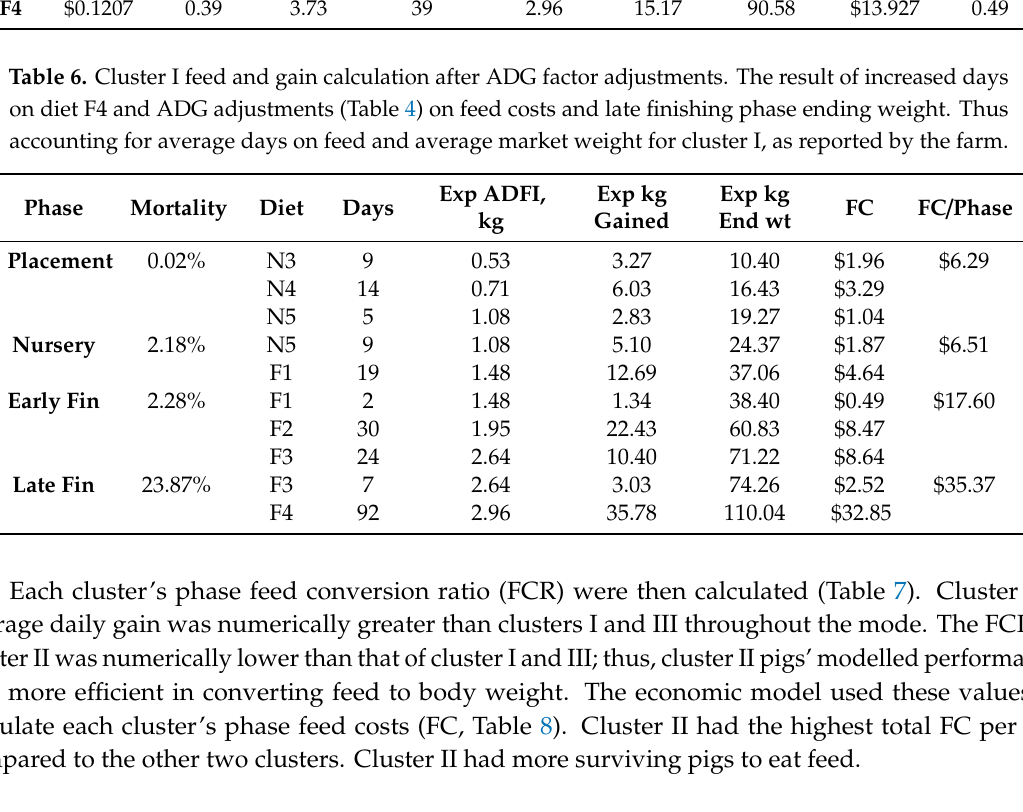
Table 7. The modelled average daily gain (ADG) and feed conversion ratio (FCR) for each cluster by phase are below. Cluster I and cluster III had the highest conversion ratio across all phases and the lowest ADG. Cluster II, the lowest FCR and the highest average daily